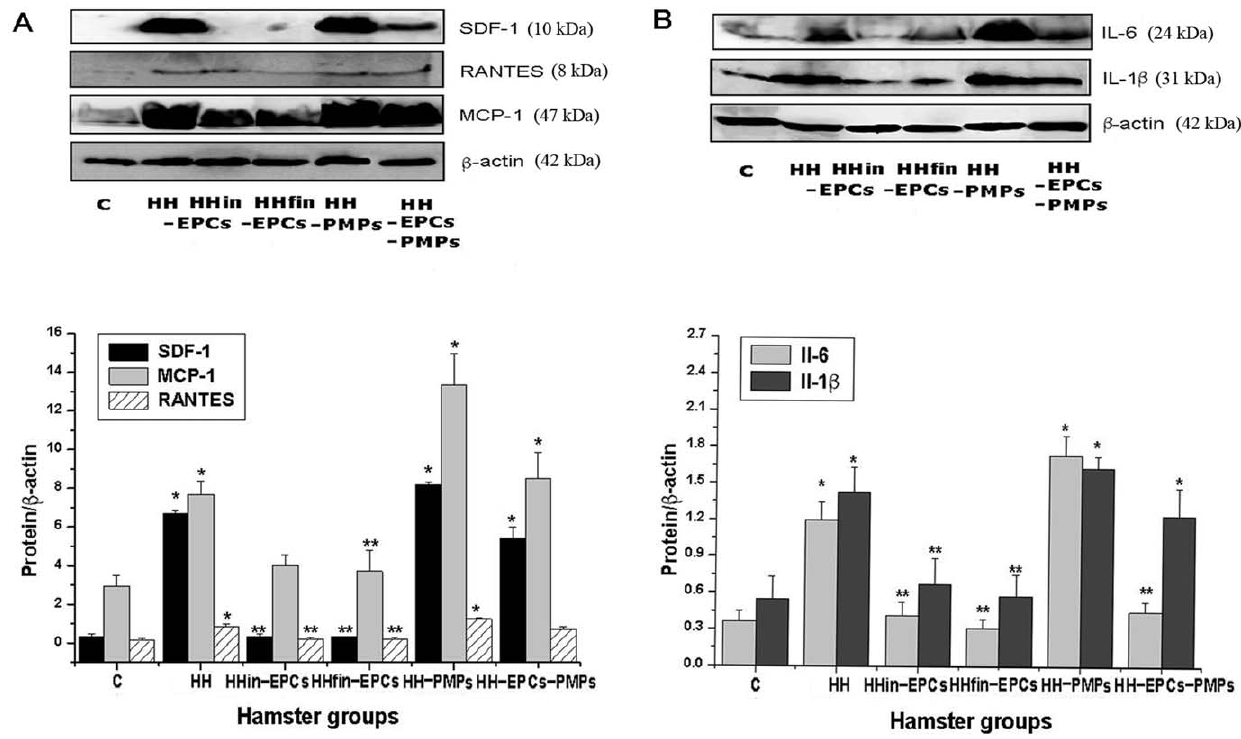
Figure 3. Representative immunoblots and quantification by densitometric analysis for pro-inflammatory molecules released by platelets isolated from the hamsters groups: control (C), hypertensive-hypercholesterolemic (HH), prevention (HHin-EPCs), regression (HHfin-EPCs), HH treated with PMPs (HH-PMPs) and HH treated with EPCs and PMPs (HH-EPCs-PMPs). (A): SDF-1, RANTES, MCP-1, b - actin, (B): Il-6, Il-1 b , b - actin. (*) Groups vs Control: p # 0.05. (**) Groups vs HH: p #